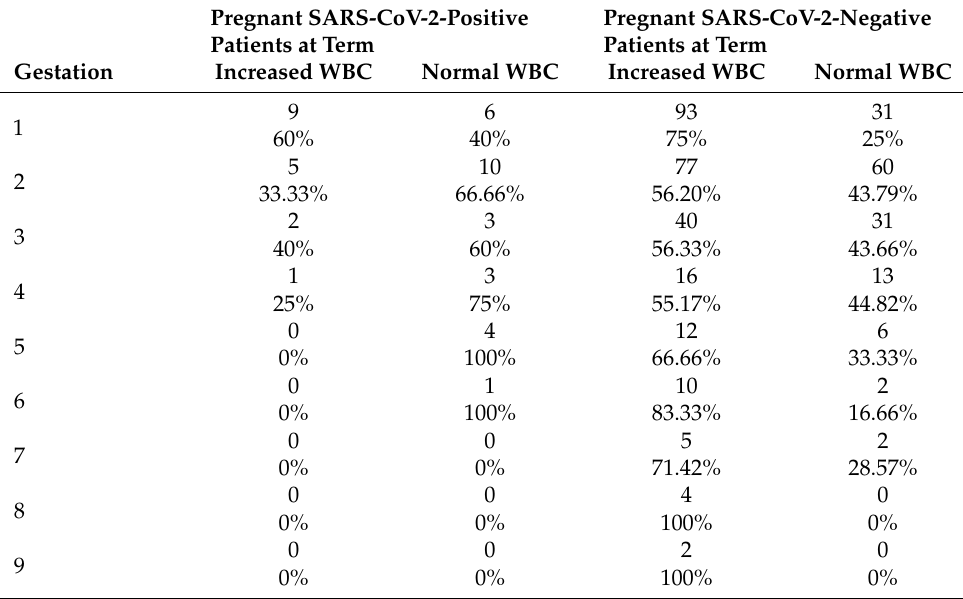
Table 4. Number and percentage of pregnant SARS-CoV-2-positive and negative patients with WBC increased over normal limits at term regarding gestation